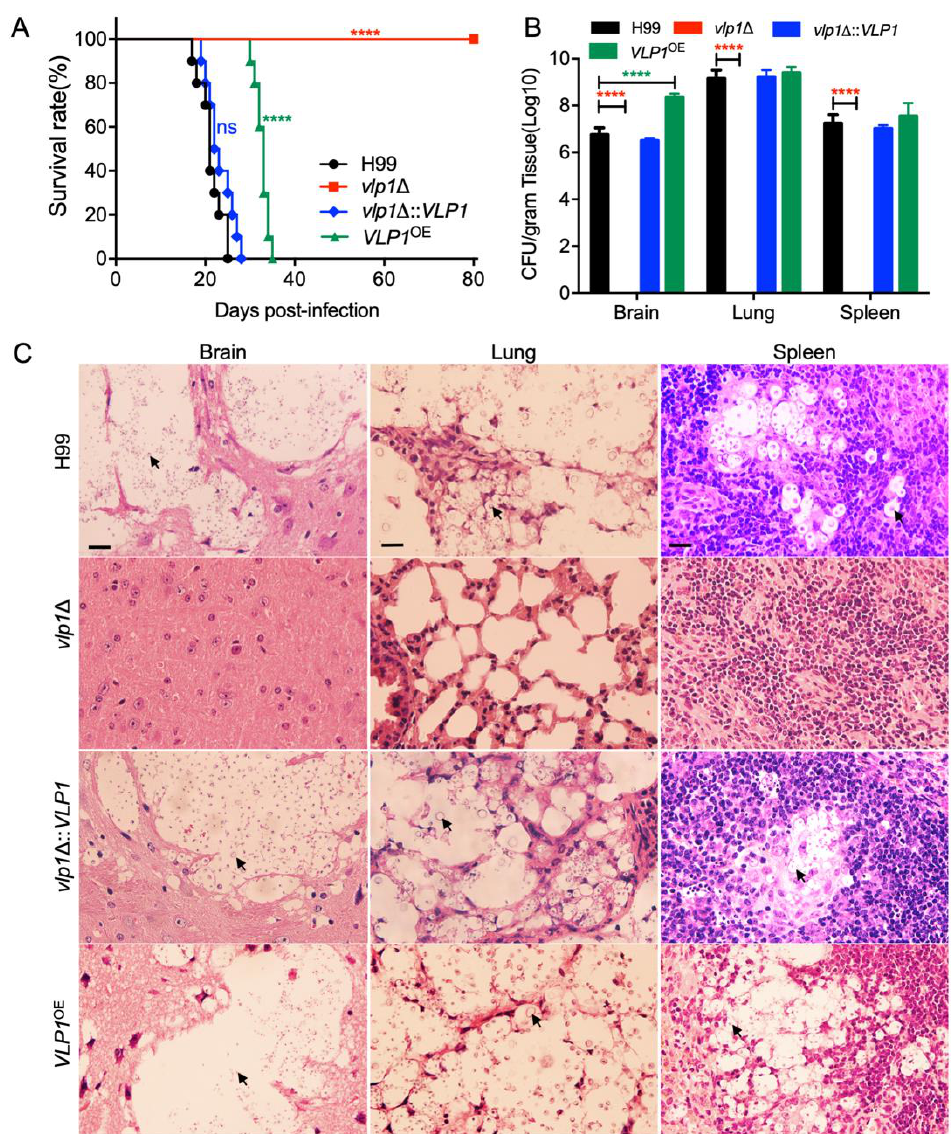
Figure 3. Vlp1 regulates fungal pathogenicity in C. neoformans . C57 BL/6 mice (10 mice per group) were used to examine the pathogenicity of each cryptococcal strain. ( A ) Survival curve of C57 BL/6 mice infected with the wild-type, vlp1 Δ mutant, VLP1 complemented, and overexpressed strains. The vlp1 Δ mutant is completely avirulent compared with the wild type. ns: not significant; ****, p < 0.0001 (determined by the log-rank (Mantel – Cox) test). ( B ) Fungal loads in brains, lungs, and spleens of Cryptococcus -infected mice at the end of the experiment. The data shown are mean ±SD of five mice. ****, p < 0.0001 (determined by Mann – Whitney test). ( C ) H&E-stained slides from the cross-sections of the organs were prepared and observed under a light microscope when the experiment was terminated. The cryptococcal cells are indicated by the arrow. Bars, 20 µm.